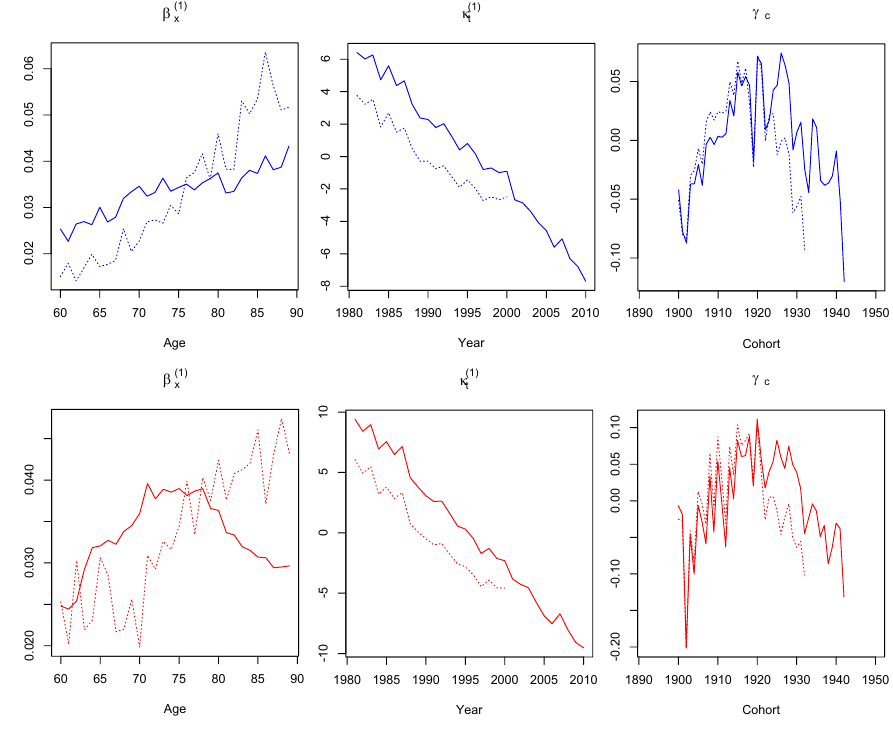
( 1 ) ( 1 ) Figure 2. M 2 : β and γ c estimated parameters for males ( top panels) and females ( bottom x , κ t panels), aged 60–89, fitted in 1981–2010 (solid lines) and 1981–2000 (dotted